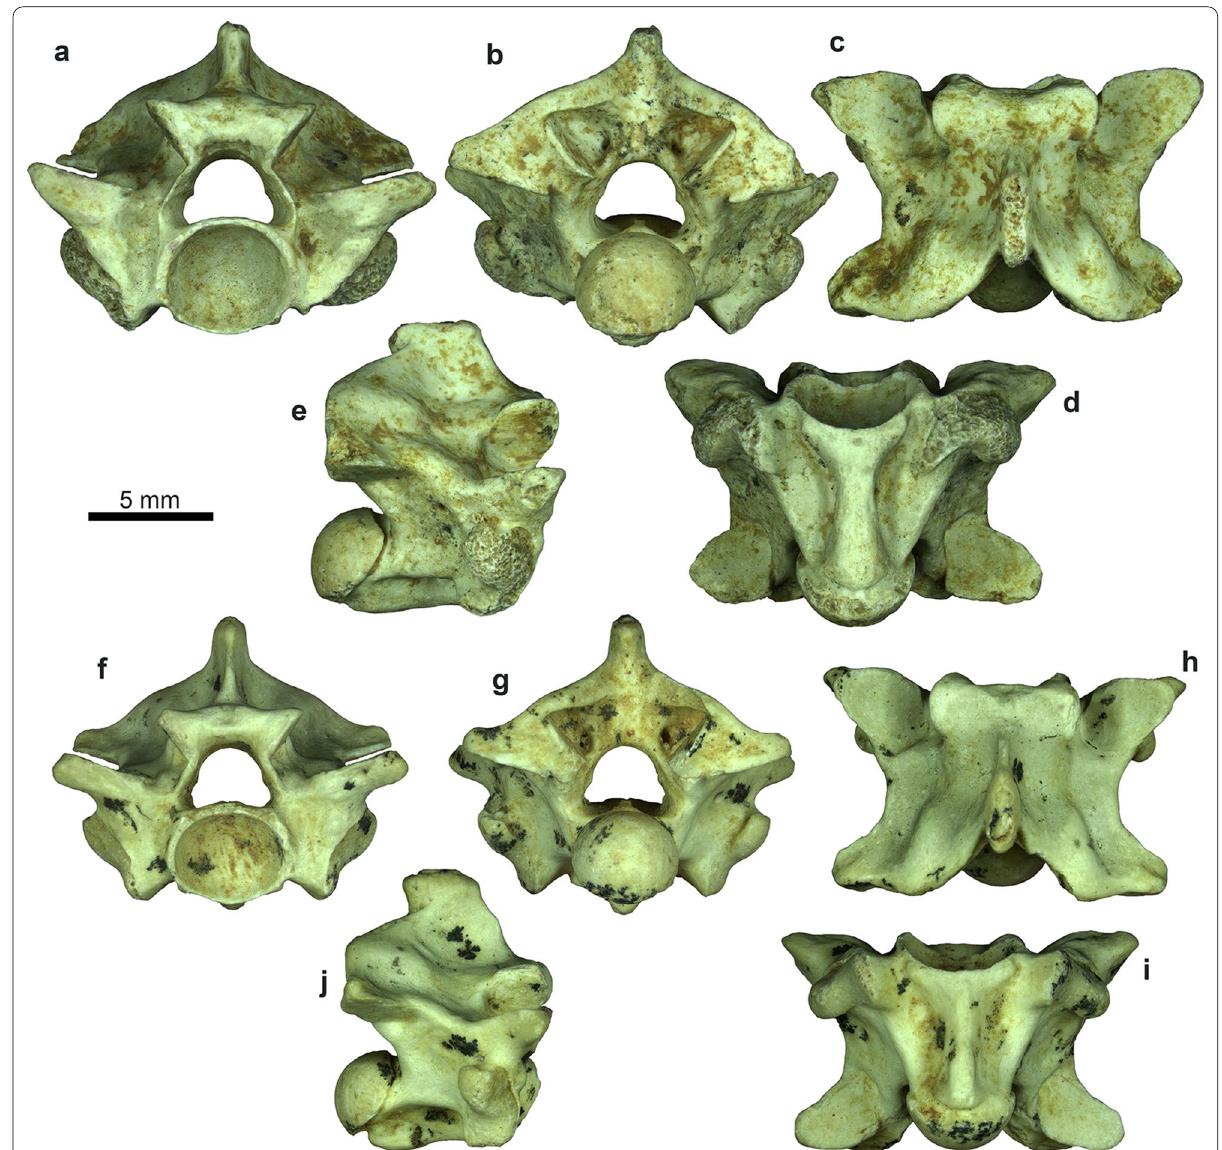
Fig. 92 Phosphoroboa filholii comb. nov. from imprecisely known locality(ies) in the Phosphorites du Quercy: a – e posterior trunk vertebra (NHMW 2019/0033/0129) in anterior ( a ), posterior ( b ), dorsal ( c ), ventral ( d ), and right lateral ( e ) views; f – j posterior trunk vertebra (NHMW 2019/0033/0153) in anterior ( f ), posterior ( g ), dorsal ( h ), ventral ( i ), and right lateral ( j )